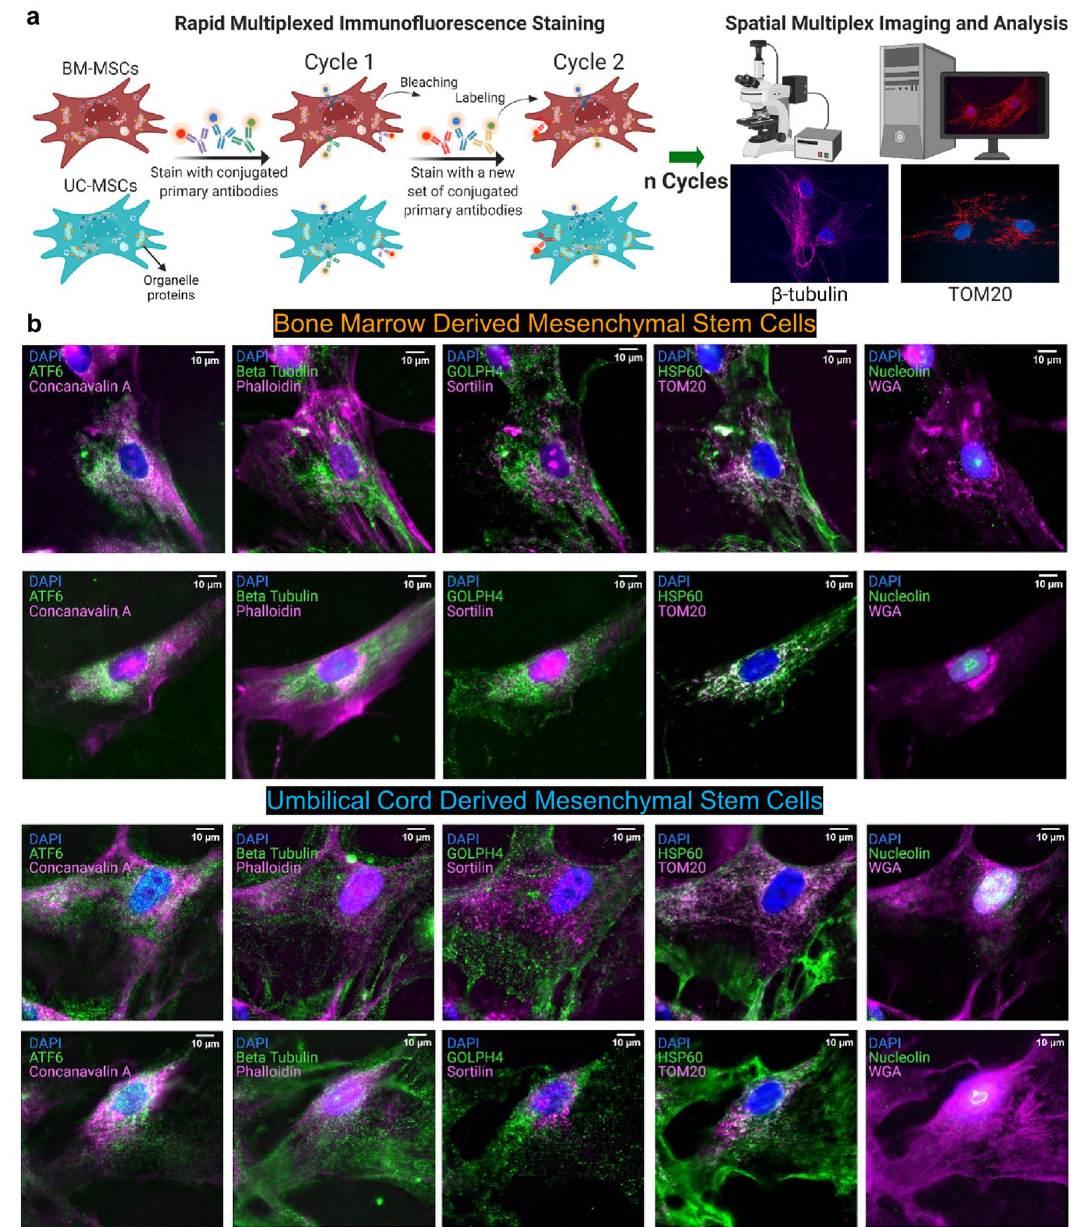
Figure 1. Ten-plex organelle mapping in mesenchymal stem cells using rapid multiplexed immunofluorescence (RapMIF). ( a ) Schematic of RapMIF for organelle analysis in MSCs. Each cycle contains 3 conjugated antibodies plus 4 ′ ,6-diamidino-2-phenylindole (DAPI) followed by bleaching of the signal before the next cycle consisting of 3 new antibodies. Imaging of the 3 antibodies before and after bleaching confirms the presence of signal and then signal removal. Multiplex imaging consists of multiple cycles (n) of antibody labeling and bleaching. BM MSCs (brown) and UC MSCs (cyan) are labeled with the same multiplex antibodies that target the same set of organelles. All images are acquired on Nikon widefield and registered across cycles to produce a final set of multiplex-labeled images. Example images show Beta Tubulin (magenta, left) and TOM20 (red, right) overlaid with the nucleus in DAPI (blue). Created with BioRender.com. ( b ) Visualization of organelle markers in single cells from BM MSCs and UC MSCs. Each row corresponds to a distinct single cell. The top 2 rows show BM MSCs and the bottom 2 rows show UC MSCs. Multiplexed markers for the same cell are displayed across 4 columns (Column 1: ATF6 & Concanavalin A, Column 2: Beta Tubulin & Phalloidin, Column 3: GOLPH4 & Sortilin, Column 4: HSP60 & TOM20, Column 5: Nucleolin & WGA). Each image displays DAPI with a pair of organelle markers in magenta and green. DAPI is used to register the signals across cycles. Signal removal is confirmed with a widefield microscope after bleaching each cycle. All scale bars 10